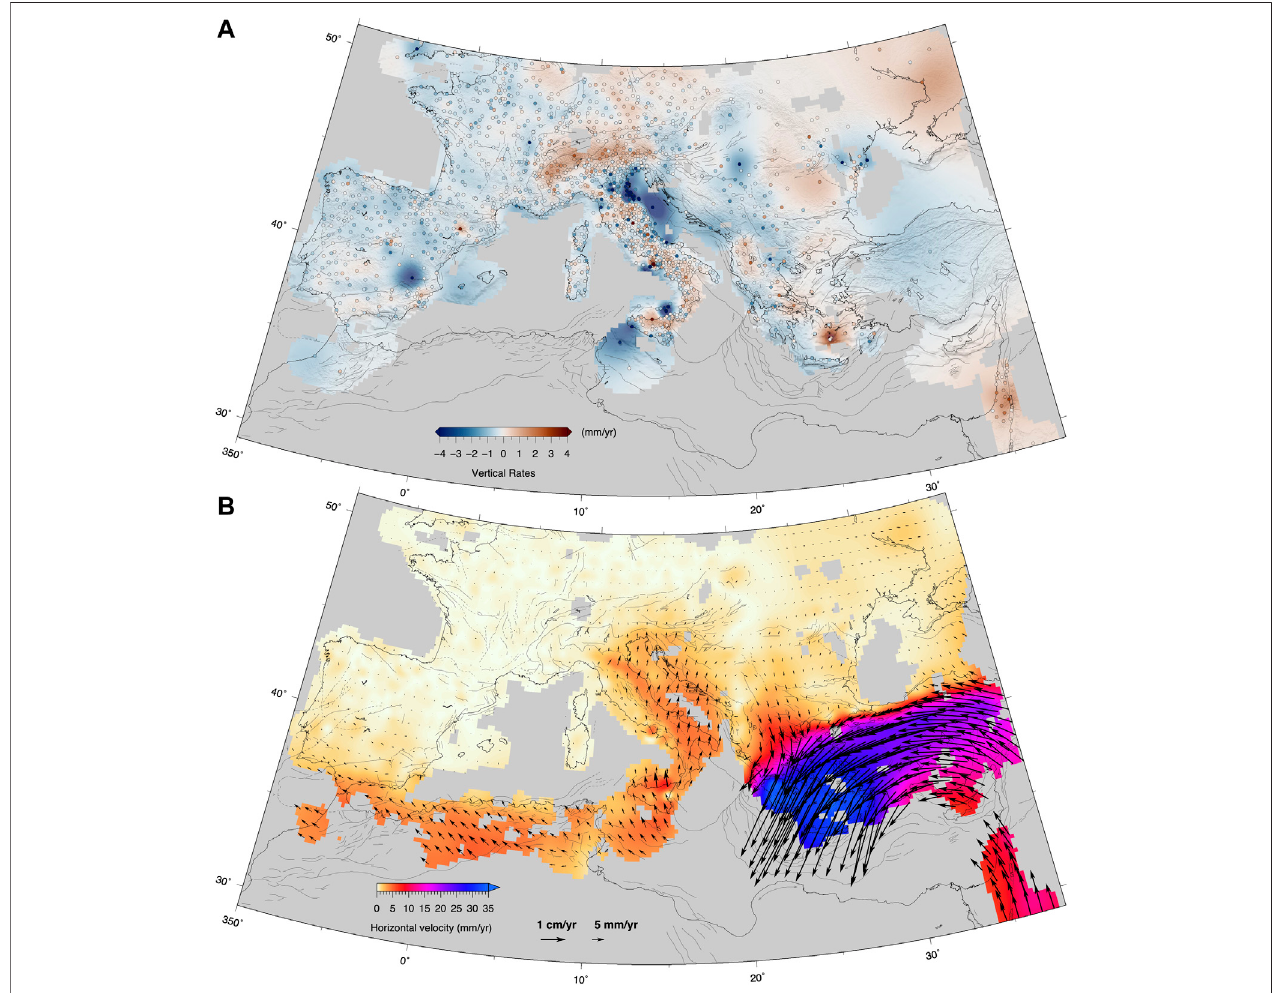
FIGURE 8 | Continuous vertical (A) and horizontal (B) velocity fi elds in the Eurasia- fi xed frame obtained by adopting the multiscale spherical wavelets approach from Tapeet al.(2009).We mask regionsoftheestimated vertical velocity fi eldbased onthe diagonal terms ofthe posterior datacovariance.Theregions shown incolor are resolved to a minimum length scale of ~55 km (q = 7). The dashed lines show the traces of the cross sections discussed in Section 5 .